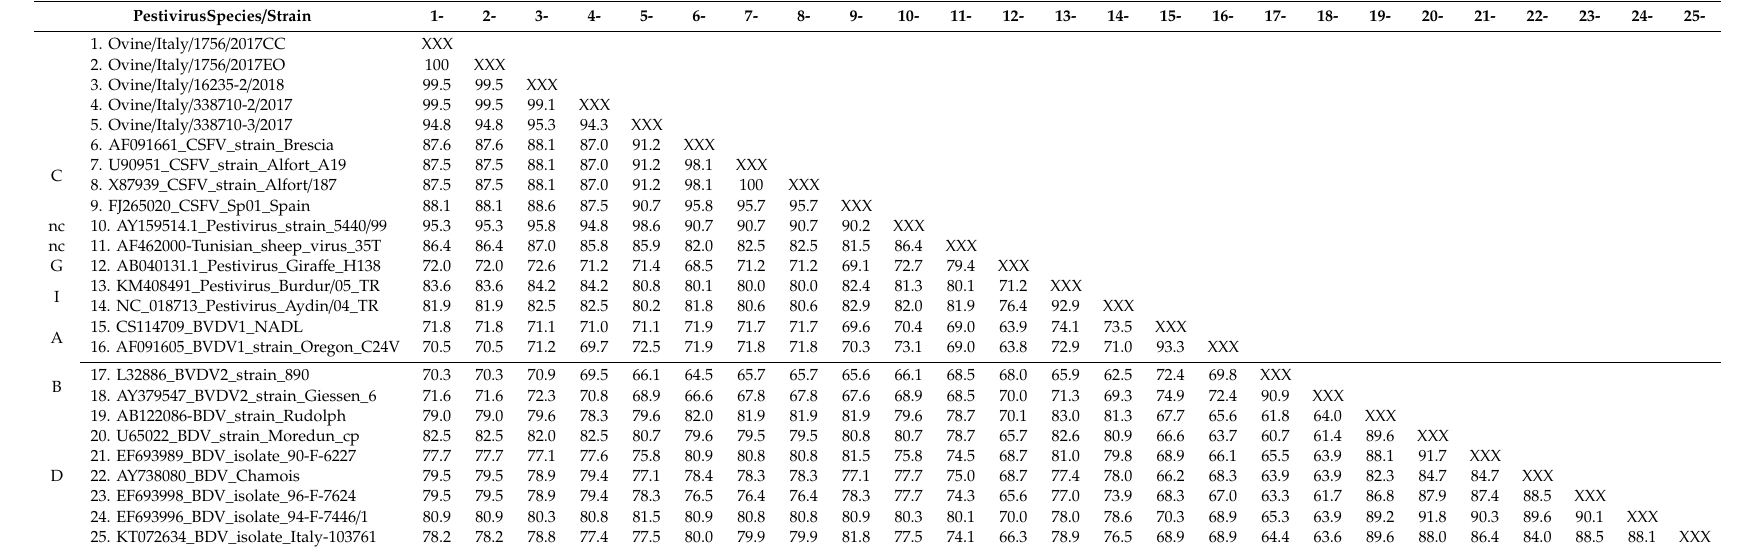
Table 2. Comparisons of nucleotide sequences of 5 (cid:48) -UTR of the sheep pestiviruses identified in this study (Ovine / IT / 1756 / 2017-CC and -EO, Ovine / IT / 338710-2 / 2017, Ovine / IT / 338710-3 / 2017, and Ovine / IT / 16235-2 / 2018) and pestiviruses classified in other species. Bold lines identify strains belonging to the same species / group (nc =